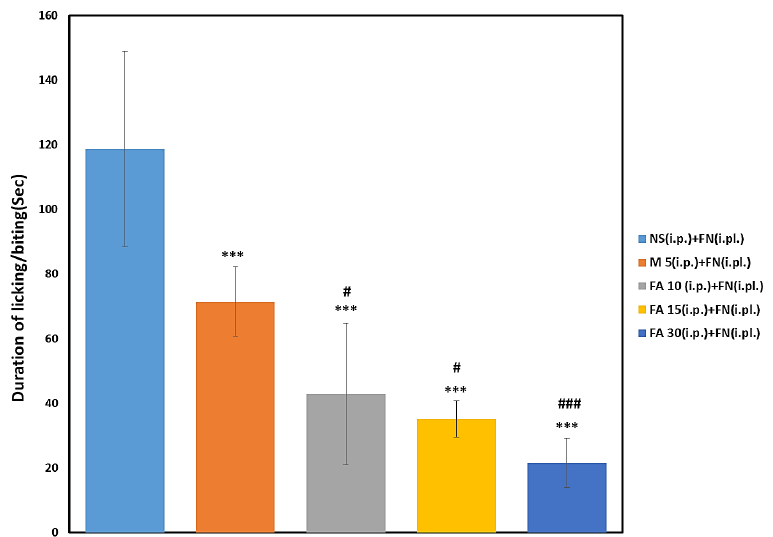
Figure 2. Effects of i.p. injection of morphine (5 mg/kg) and different doses of folic acid (10, 15 and 30 mg/kg) on 2nd phase (20-40 min) response to formalin-induced pain in mice. *** P < 0.001 vs control group (NS+FN); # P < 0.05 and ### P < 0.001 vs morphine group (M+FN). NS: normal saline; FN: formalin; FA: folic acid; M: morphine; i.p.: intraperitoneal; i.pl: intraplantar.